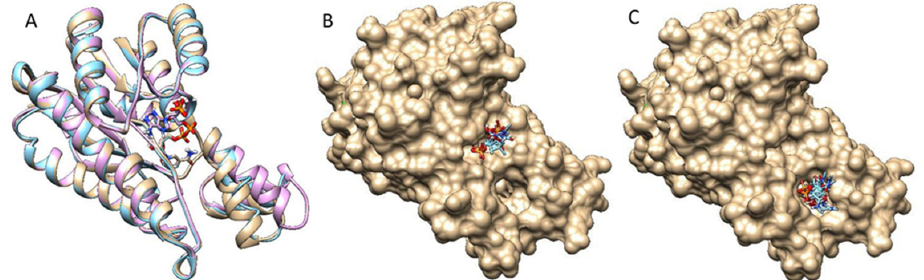
Figure 3. DM- Act KR monomer conformation comparison and two major binding motif clusters generated from docking analysis on octaketide-bound DM- Act KR monomer (closed conformation). ( A ) Visualization of aligned monomers among the structures originally containing: octaketide-bound (gold), tetraketide-bound (cyan), and no ligand (pink). The NADPH present in all three structures is displayed; ligands deleted for clarity. ( B ) The front-patch binding motif. ( C ) The back-patch binding motif. The protein and NADPH surface are displayed in gold.